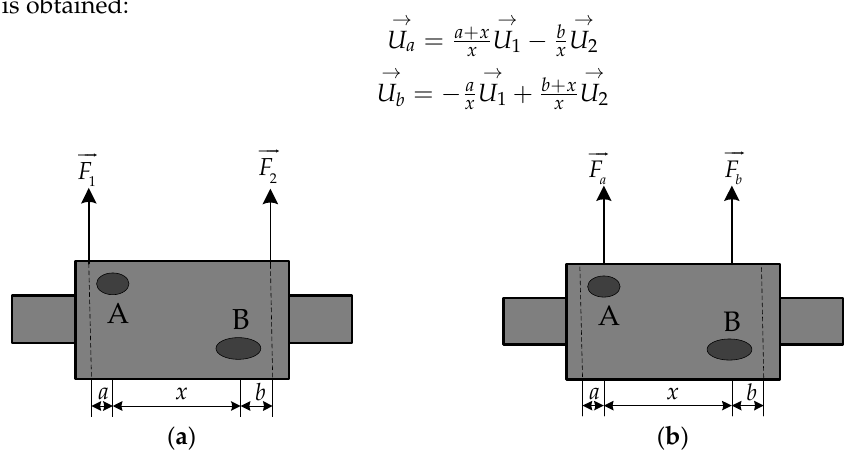
Figure 6. Force decomposition of unbalanced rotor: ( a ) original force; ( b ) force after decomposition.